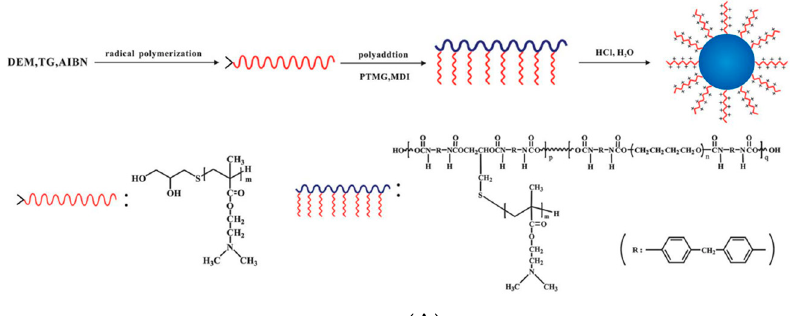
Figure 10. Schematic representation of pH-induced emulsification and demulsification using shell cross-linked micelles as particulate emulsifiers. Dewetting from the oil droplet surface occurs at low pH. Reprinted with permission from [103]. Copyright 2005, American Chemical